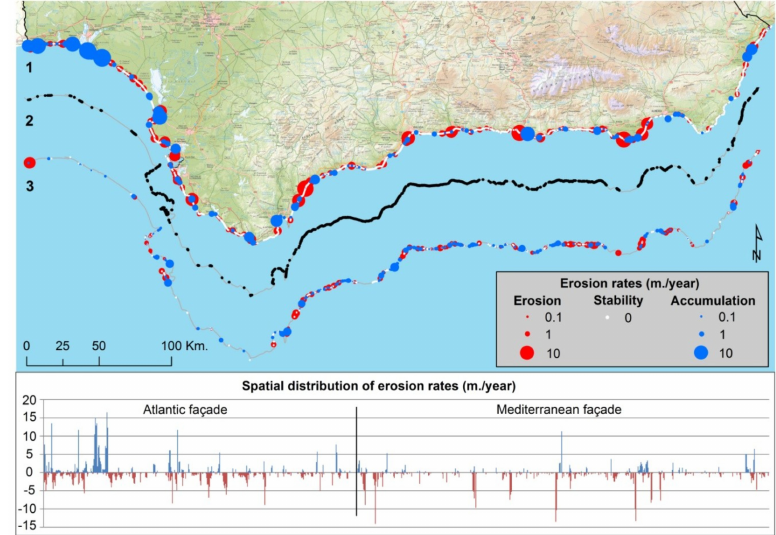
Figure 10. Erosion rates for urban beaches and beaches affected by any coastal infrastructure. The combination of thematic information and erosion rates in a single database allow the user to assess the effect of the built environment on the erosion rates. The three shorelines represent: (1) erosion rates for the most recent period (2001 and 2011), (2) urban beaches and beaches associated with any infrastructures in 2011, and (3) erosion rates over the time period 1977–2001 in beaches with stable tendency due to the presence of a built environment in the most recent